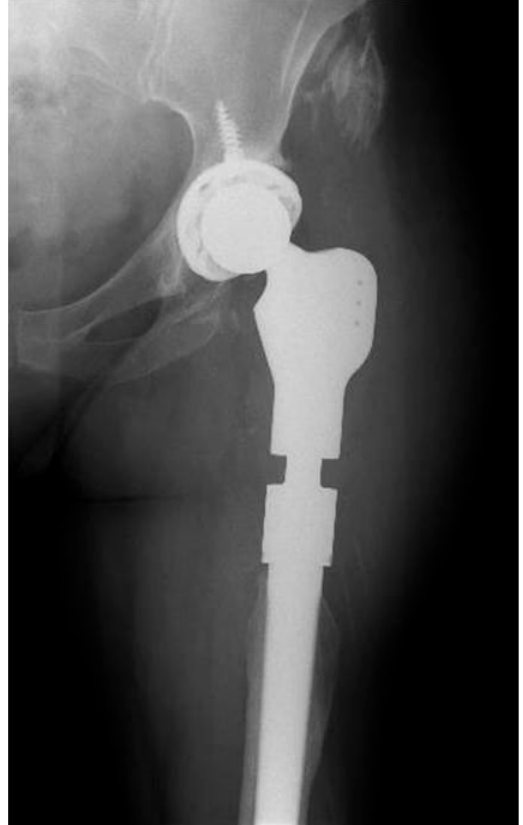
Figure 4. Hip radiology with implanted megaprosthesis with four-years follow-up.